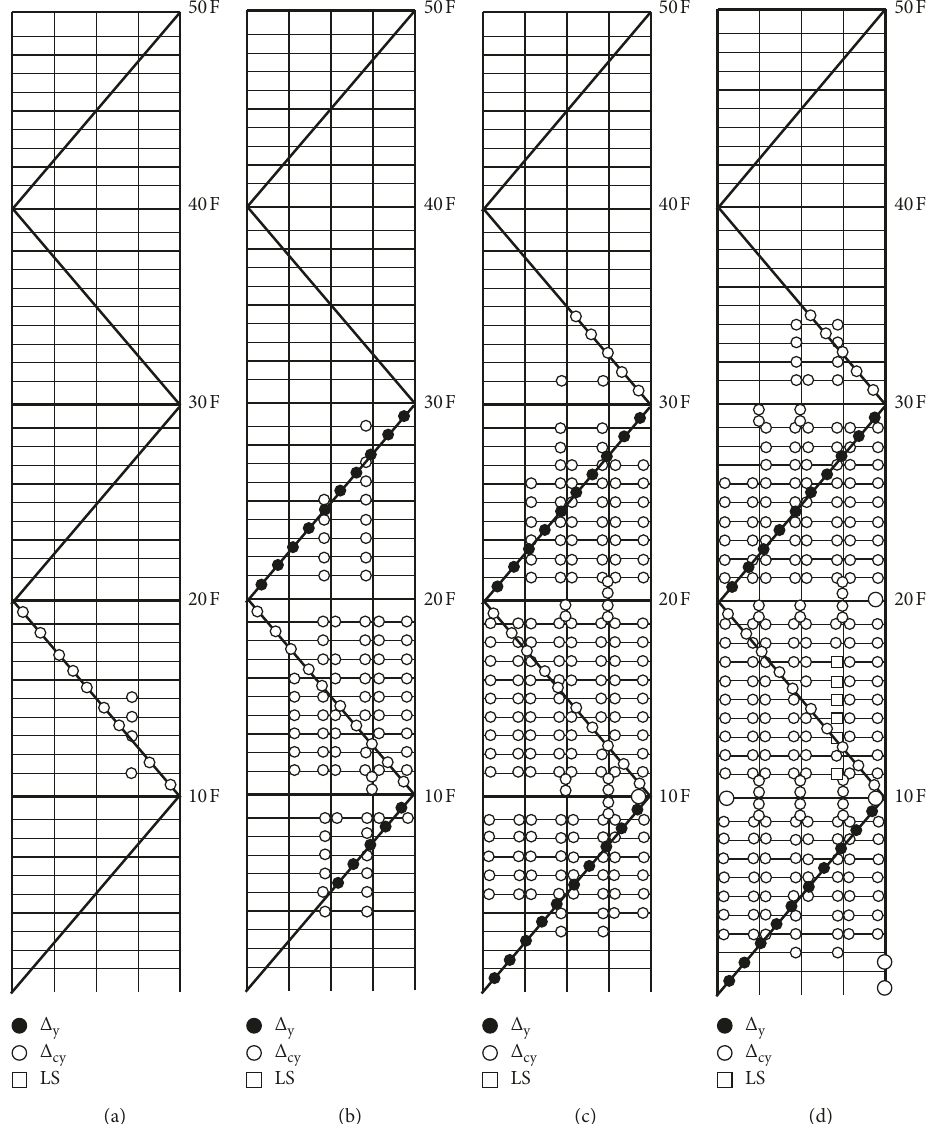
Figure 8: Plastic hinge formation in the web-side frame of model 5MBC: (a) first yield ( δ (c) primary beam yield ( δ